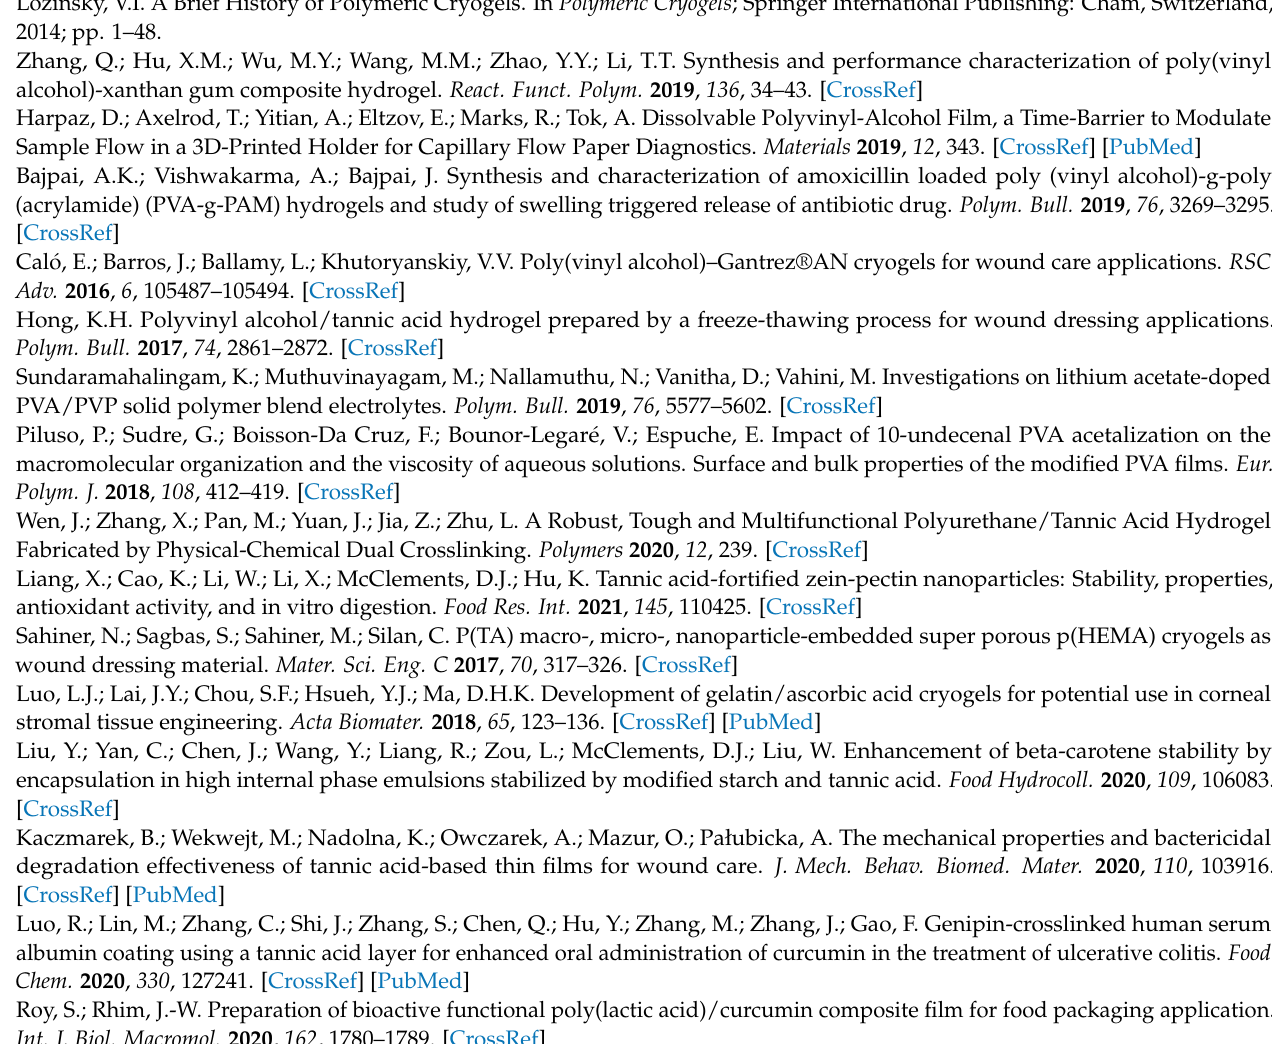
Antibacterial Material. Table S1. The temperatures corresponding to 5% and 10% weight loss of